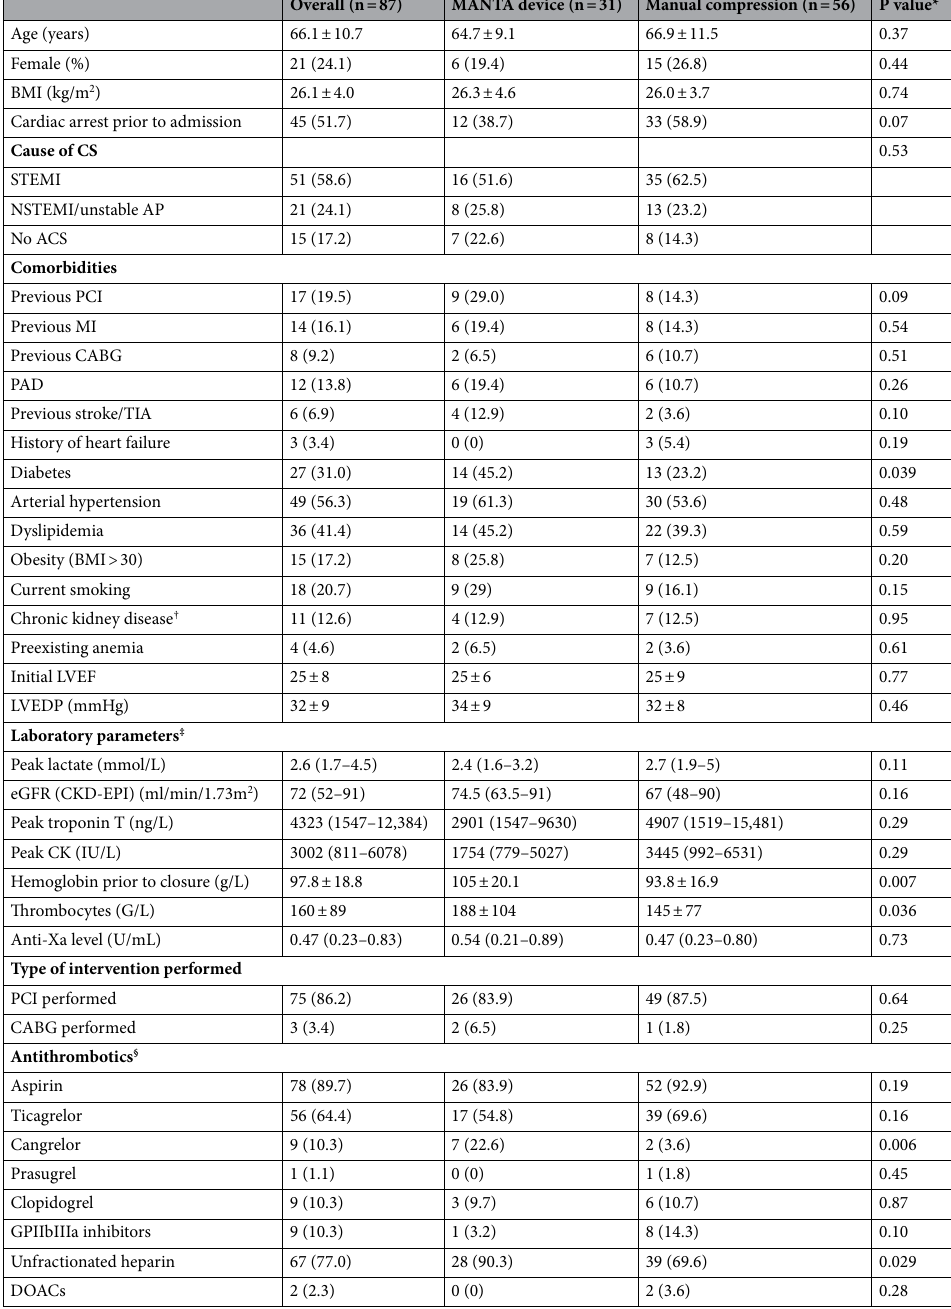
Table 1. Baseline demographics grouped according to the access closure strategy on ICU. Data are median (interquartile range) or number (percentage), as appropriate. AP, angina pectoris; BMI, body mass index; CS, cardiogenic shock; STEMI, ST-segment–elevation acute myocardial infarction; NSTEMI, non–ST-segment– elevation myocardial infarction; PCI, percutaneous coronary intervention; MI, myocardial infarction; PAD, peripheral arterial disease; CABG, coronary artery bypass grafting; TIA, transient ischemic attack; Hb, hemoglobin; LVEF, left ventricular ejection fraction; LVEDP, left ventricular end diastolic pressure; eGFR (CKD-EPI), estimated glomerular filtration rate (Chronic Kidney Disease Epidemiology Collaboration); CK, creatine kinase; DOAC, direct oral anticoagulant agents. *P values were based on Fisher’s exact, Man- Whitney-U test or student’s t-test, as appropriate. † Chronic kidney disease was defined as a preexisting eGFR < 45 ml/min/m 2 . ‡ Values of laboratory parameters prior to access closure are represented (either first or peak, as appropriate). § This comprised antithrombotics, which had been administered after Impella implantation and/or prior to device